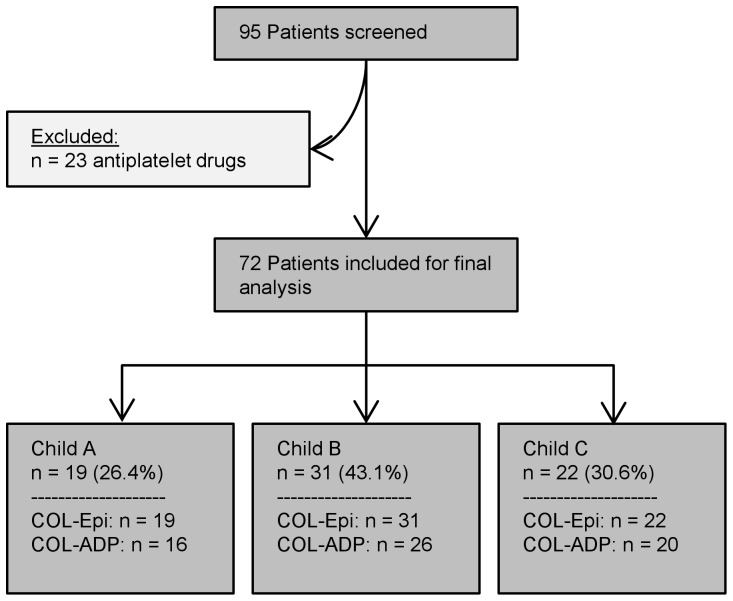
Selection of the study population.The enrolment details of the study population are shown, including the number of patients excluded because of the use of antiplatelet drugs or because there was no information on use of these drugs. For all subgroups, the number of available test results for PFA-100 with Col-Epi and Col-ADP is given.